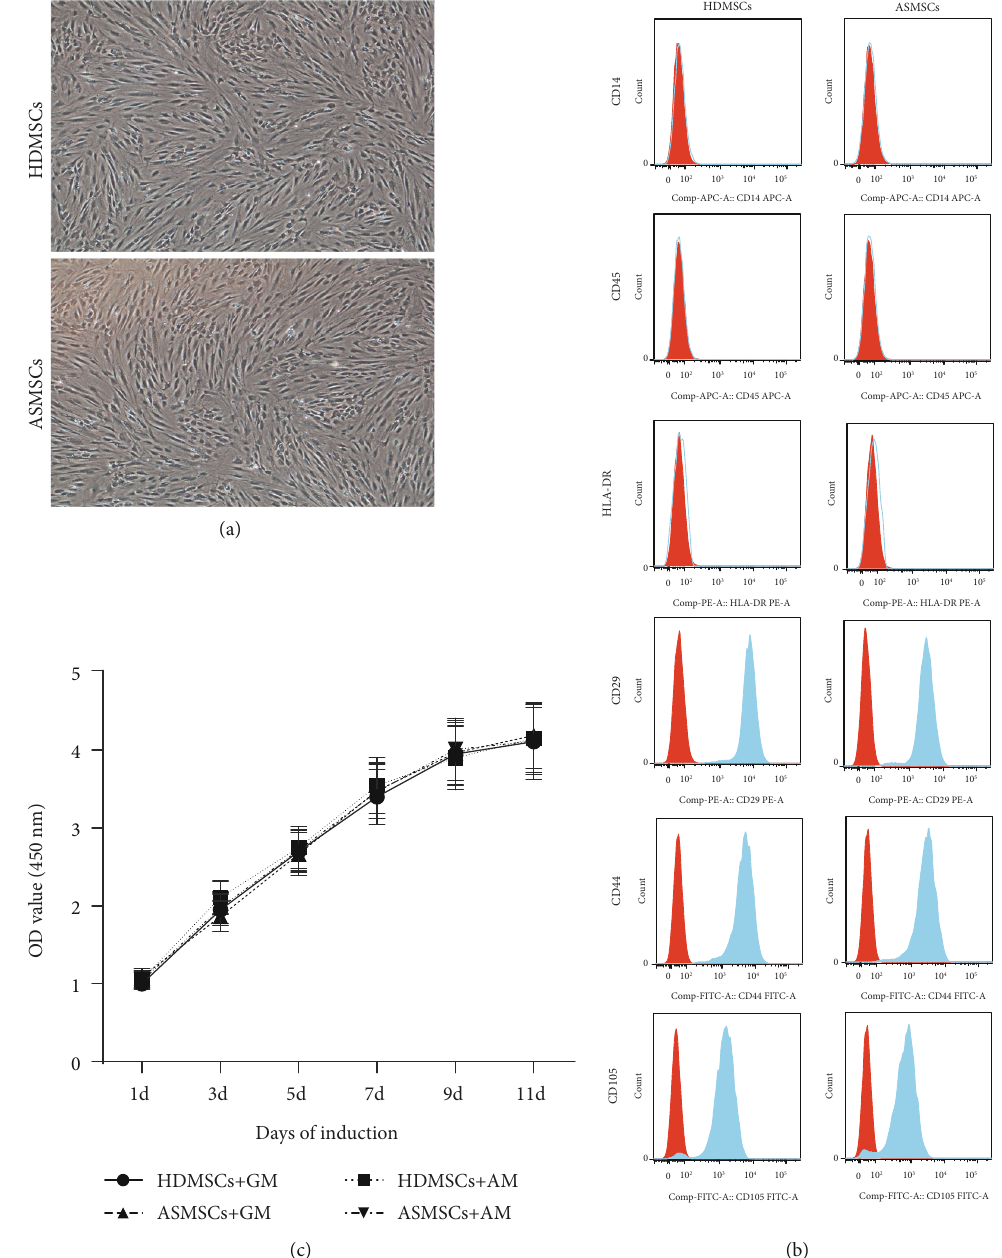
Figure 1: HDMSCs and ASMSCs exhibited similar morphologies, phenotypes, and proliferation rates. (a) HDMSCs and ASMSCs were both spindle-shaped, plastic-adherent cells. (b) HDMSCs ( n = 30 ) and ASMSCs ( n = 25 ) were negative for CD14, CD45, and HLA-DR and positive for CD29, CD44, and CD105, indicating a typical MSC phenotype. (c) HDMSCs ( n = 30 ) and ASMSCs ( n = 25 ) displayed equal proliferation capacities when cultured in either GM or AM from 1 to 11 days. The optical density (OD) values shown in (c) are presented as the means ± SDs